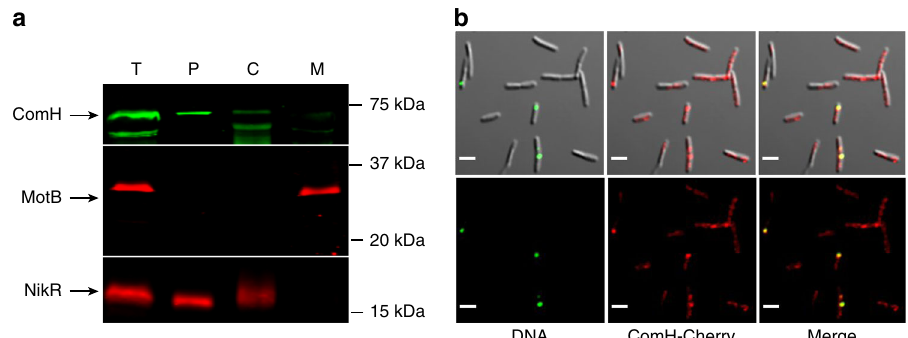
Fig. 2 ComH is present in the periplasm where it co-localises with tDNA foci. a ComH-Flag was ectopically expressed in a Δ comH strain and the presence of the protein in the different subcellular compartments was detected by immunoblotting. T: Total extract, P: periplasm, C: cytoplasm, M: membrane. MotB and NikR were used as controls for the fractionation experiments. b Co-localisation of ComH-mCherry expressed in a Δ comEC strain from its own locus with ATTO-488-dUTP labelled transforming DNA. Z maximum projections of merged and separate images of ATTO-488 (green channel), ComH-mCherry (red channel), and differential interference contrast are presented. Scale bar = 2.5 µ